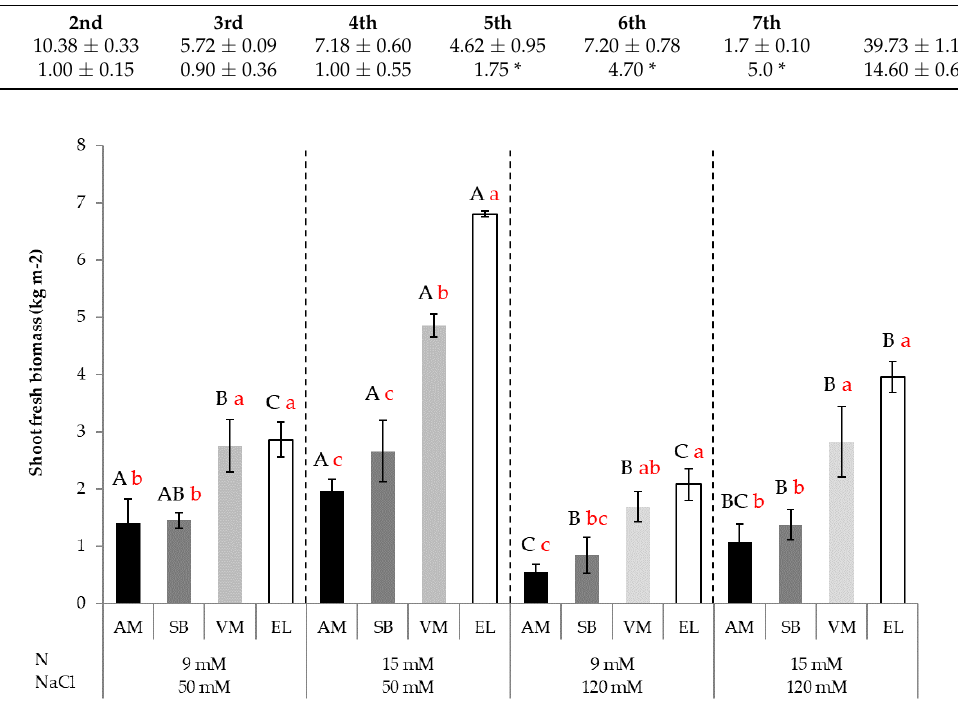
Figure 1. Fresh shoot biomass in Arthrocnemum macrostachyum (AM), Salicornia brachiata (SB), and Sarcocornia fruticosa ecotypes (EL and VM). LN under different combinations of N (9 and 15 mM) and NaCl (50 and 120 mM). Means plus standard errors ( ± SE) are shown. Different uppercase letters show significant differences between treatments of one ecotype (same color bars), and different lowercase red letters show significant differences between ecotypes within the same treatment (Tukey’s HSD, p ≤ 0.05, n = 4).